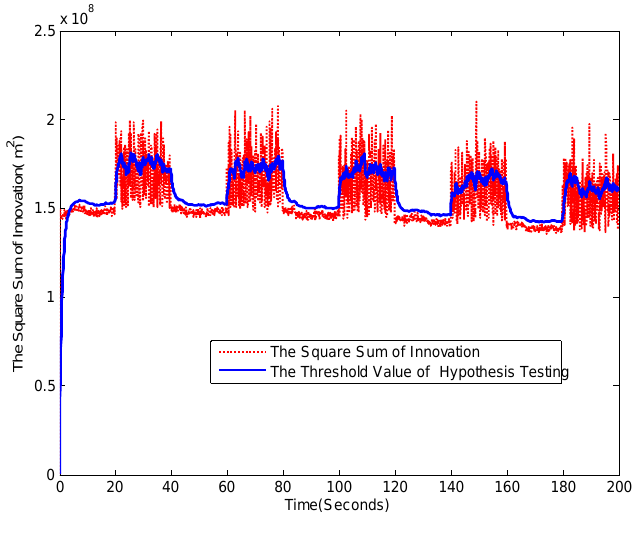
Figure 5. The identification results of the LOS/NLOS hypothesis testing.